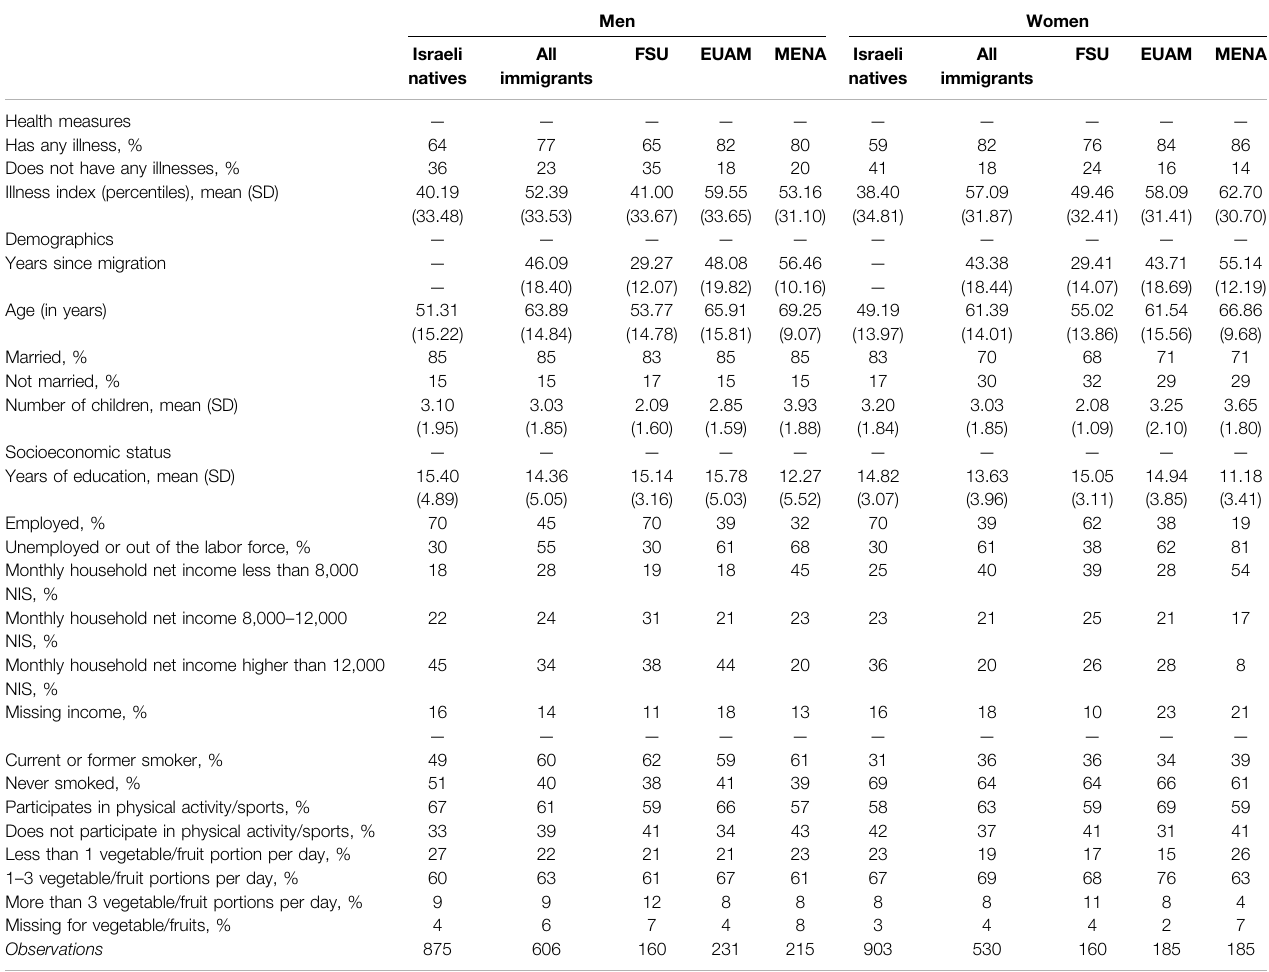
TABLE 1 | Means and distributions of variables, by nativity status and